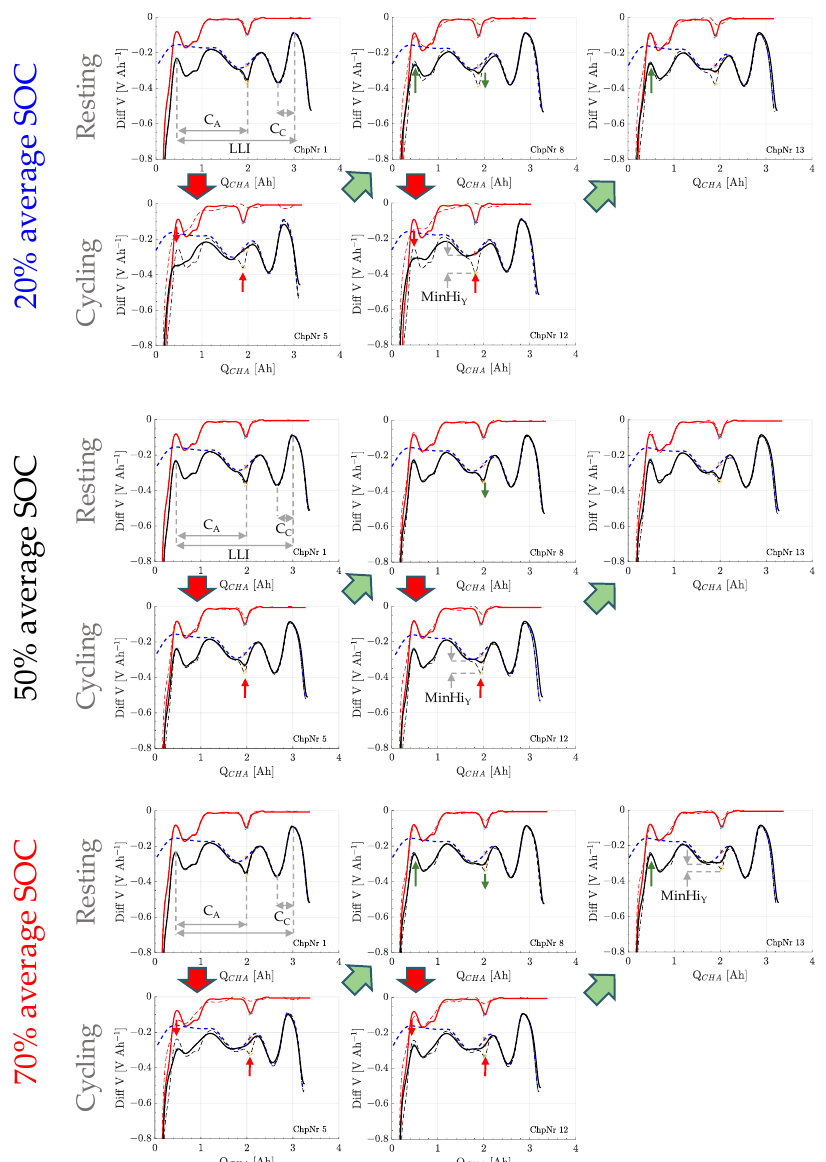
Figure 8. DVA for three cells cycled at 20%, 50%, and 70% average SOC with 20% DOD and charge/discharge currents of 1360/2800 mA. The DVA is shown at begin of the test (1st check-up), after the 1st cycling phase (5th check-up), the 1st resting period (8th check-up), the 2nd cycling phase (12th check-up), and, finally, the 2nd resting period (13th check-up). The solid black line shows the measured full cell dV/dQ curve, the solid red line the estimated anode, and the dashed blue line the cathode (educated guess). The black dashed line shows the expected dV/dQ curve (HLD preserved). The green arrows in the graphs highlights rehomogenization and the red arrows the inhomogenization.